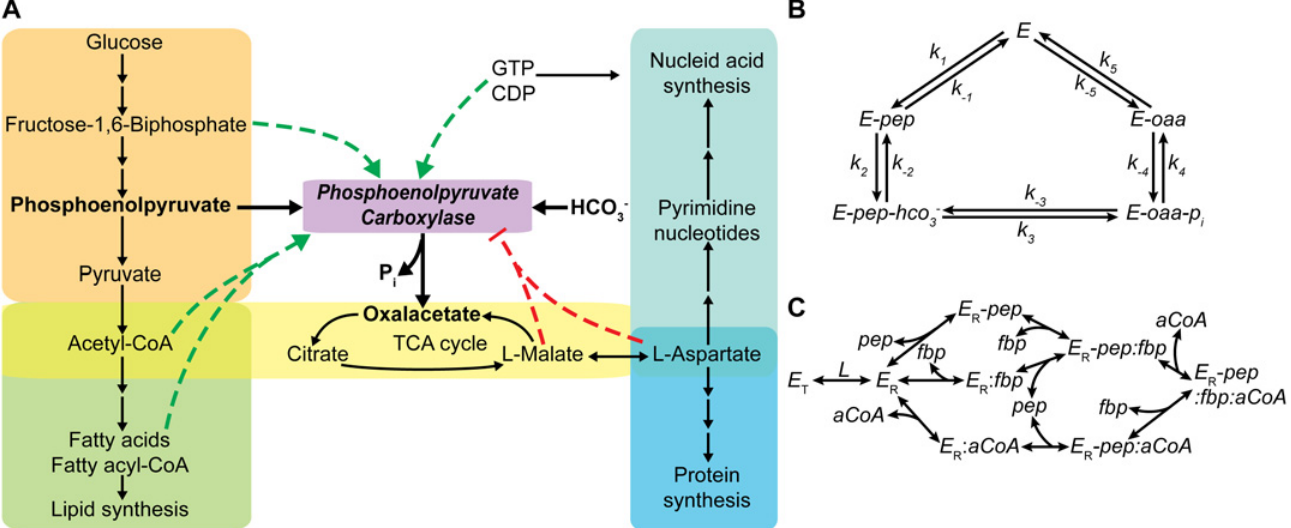
Fig 6. Complex allosteric regulatory interactions control the kinetic behaviour of phosphoenolpyruvate carboxylase (PEPC) in E . coli . (A) PEPC regulates anaplerotic metabolism in E . coli through several allosteric interactions. This enzyme carries out the conversion of phosphoenolpyruvate and bicarbonate into oxaloacetate and inorganic phosphate. All reactants are highlighted in black. The red and green dashed lines denote the inhibition and activation exerted by different effectors, respectively. (B) Ordered Bi-Bi mechanism for PEPC catalysis. Phosphoenolpyruvate, bicarbonate, oxaloacetate and orthophosphate are denoted by the abbreviations pep , hco 3 − , oaa and p i , respectively. (C) Mechanism of synergistic activation of PEPC transitions proposed by Smith et al. [57]. This mechanism considers two separate binding sites for the two types of activators (allosteric sites) and another for the substrates (catalytic site), each of them being capable of independently interacting with different enzymatic complexes. Notably, this model assumes the existence of the relaxed enzyme (active) only in the presence of activators, one of which may be the substrate pep .